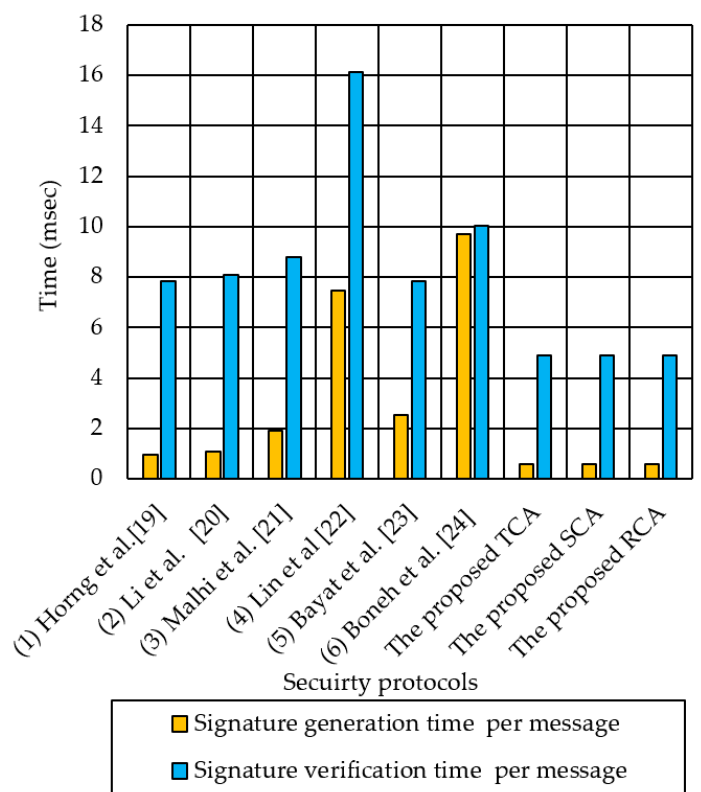
Figure 13. A comparison of signature generation time and verification time for the proposed TCA method and the six previous methods in a single-zone scenario.